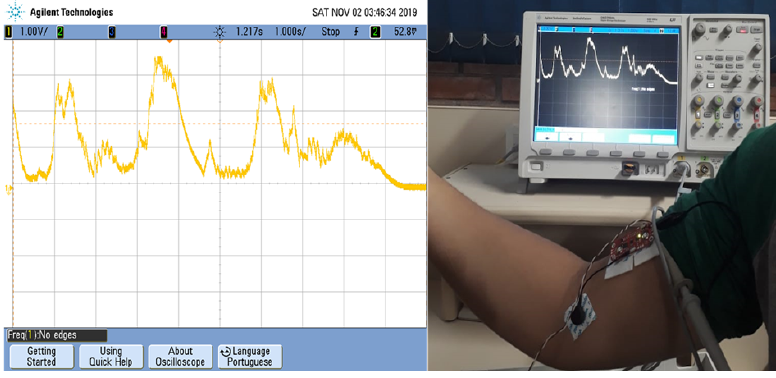
Figure 5. Test of the EMG